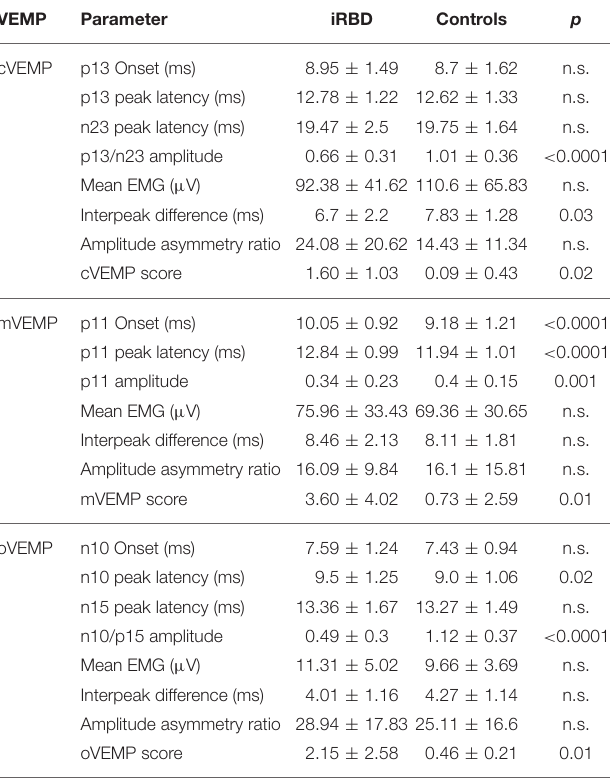
TABLE 2 | Comparison of morphological characteristics of the cVEMP, mVEMP and oVEMP between iRBD patients and controls. VEMP